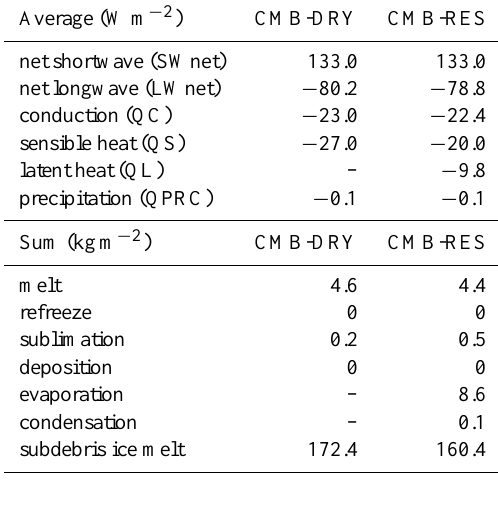
Table 5. Average-energy and accumulated-mass fluxes at the sur- face over the 2011 simulation for CMB-RES and CMB-DRY.